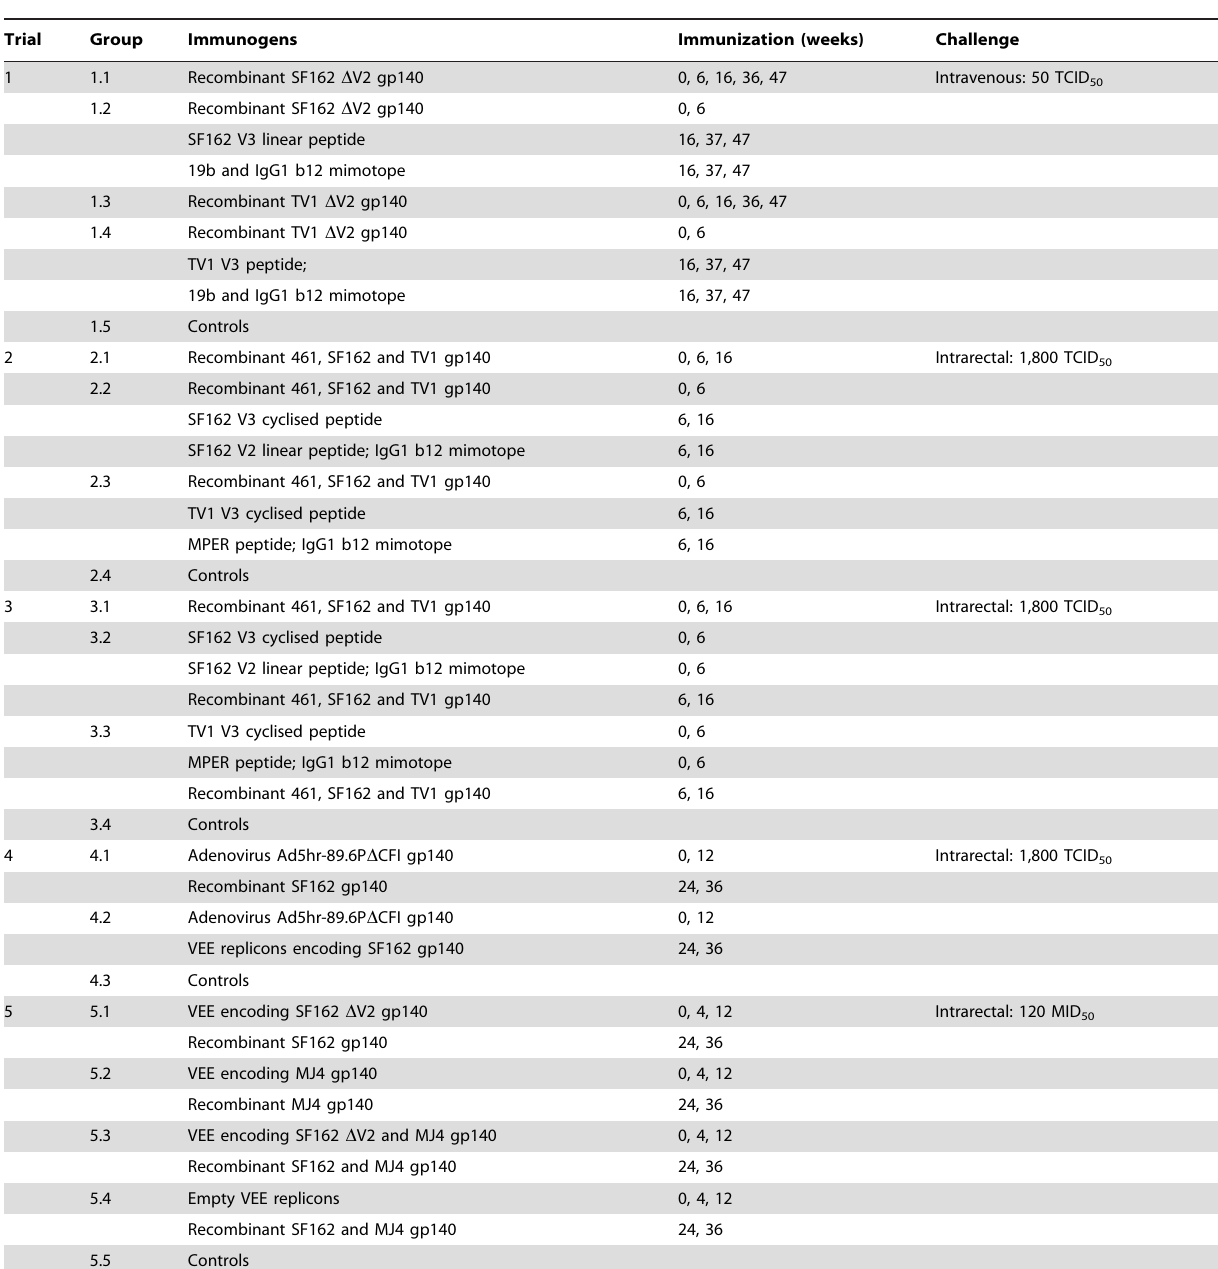
Table 1. Summary of sources of sera from immunogenicity trials in rhesus macaques.